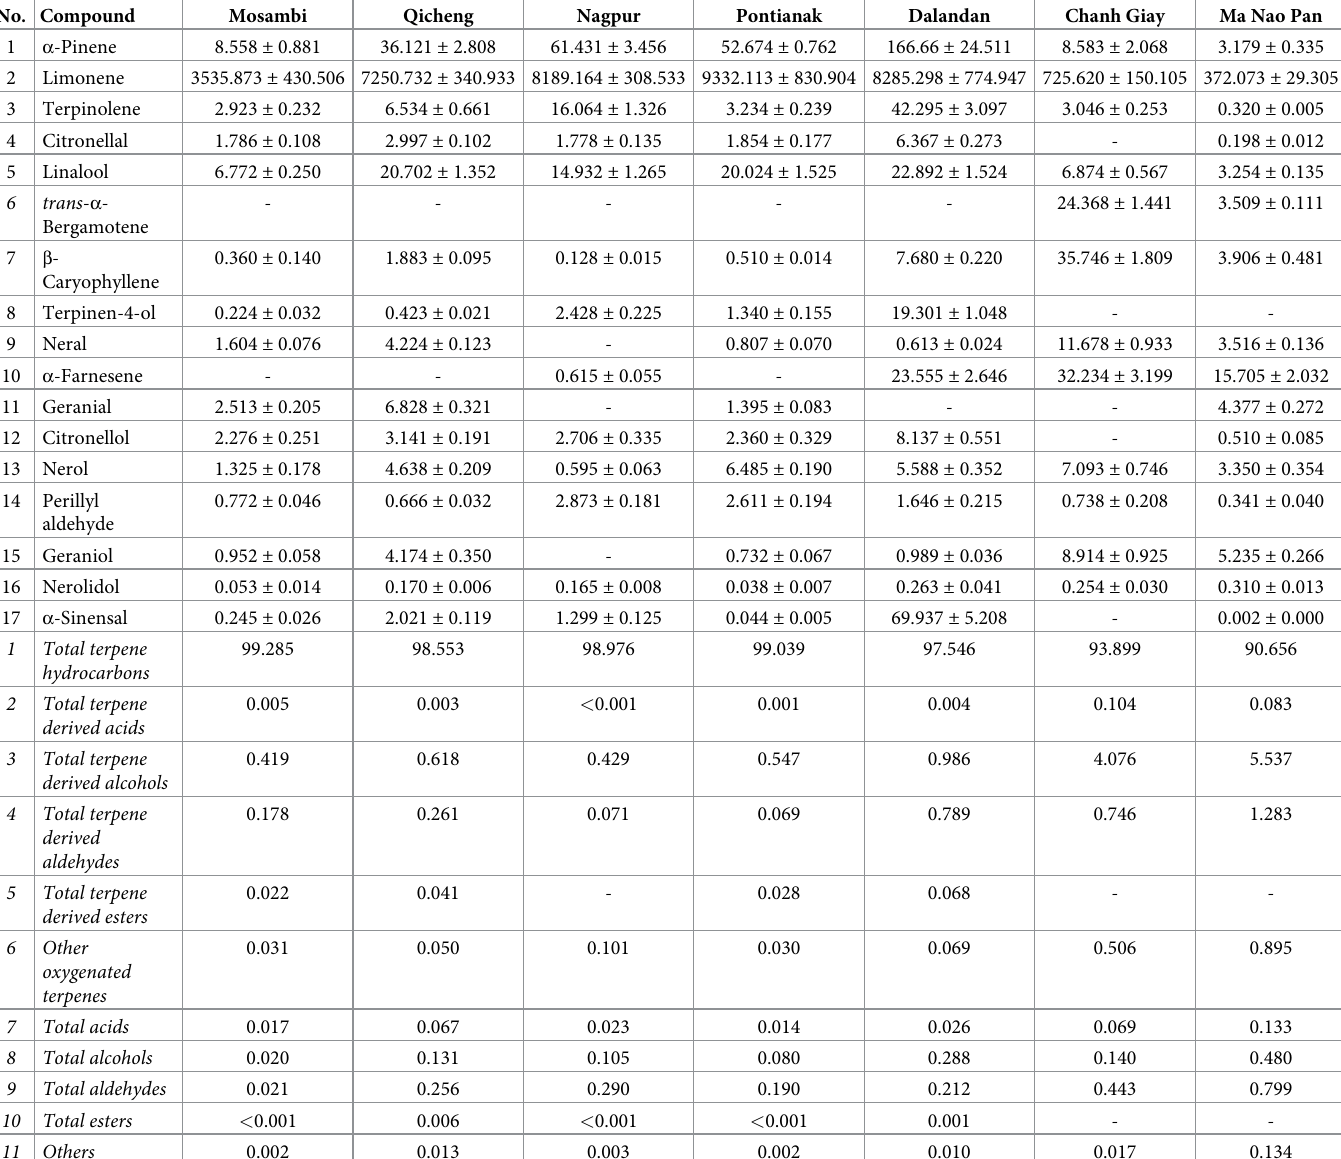
Table 3. Key volatile compounds (expressed in μ g/mL) and volatile compounds sorted by functional class (expressed in percentage of total concentration (%)) in cit- rus